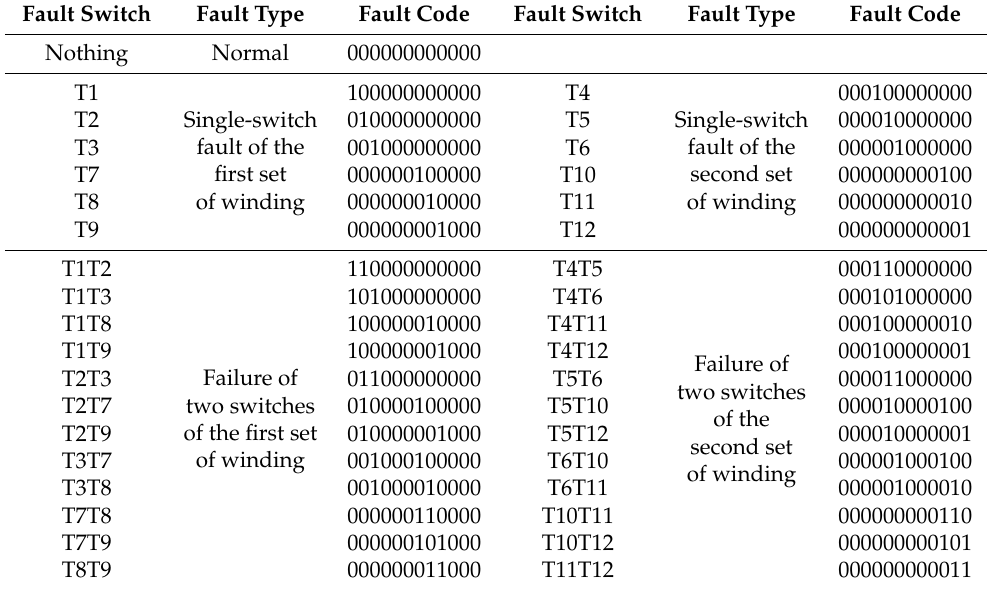
Figure 6. Reference direction of i z1 and i z2 current trace, in the case of two-power-switch faults. Table 1. Fault type